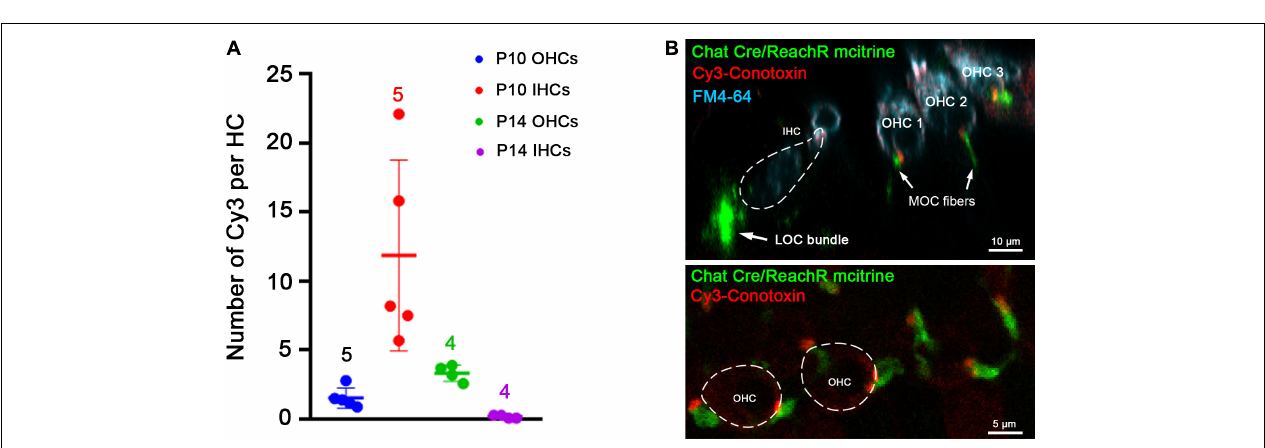
FIGURE 5 | Cy3-RgIA-5727 label in Wild Type P10 cochlea. This age is near the peak of MOC innervation onto IHCs, and innervation of OHCs is well under way. (A) Maximum intensity projection (MIP) from the apical surface of the cochlea. (B) Optical yz-plane view of cochlea (MIP), three rows of OHCs on left, single row of IHCs on right, green FM4-64 accumulation fills multiple hair cells seen in depth. (C) Cy3-RgIA-5727 in yz-plane view (MIP); red puncta observed on OHCs and IHCs. (D) Merged view of FM4-64 and Cy3-RgIA-5727 (MIP). Red Cy3 puncta readily distinguished against green FM4-64 background. Inner hair cell (IHC) and greater epithelial ridge (GER) outlined with dashed lines. Images exemplify results from 12 cochleas from 12 mice. See Supplementary Video 2 .